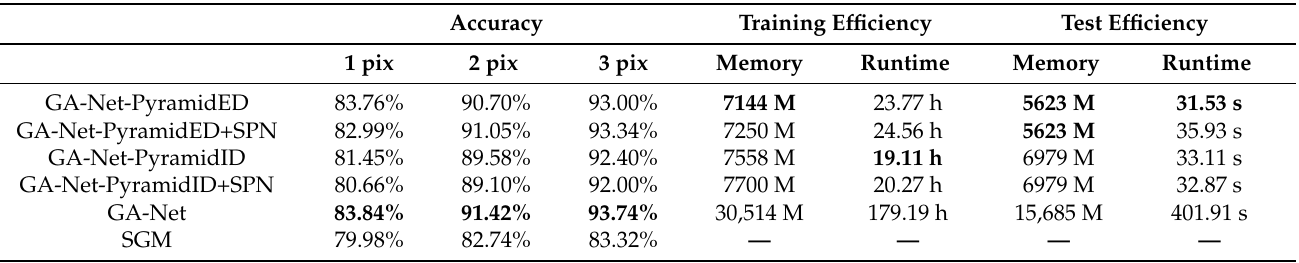
Table 6. Accuracy and efficiency comparison between GA-Net-Pyramid, including GA-Net- PyramidED and GA-Net-PyramidID, and GA-Net on satellite data (baseline model: SGM).